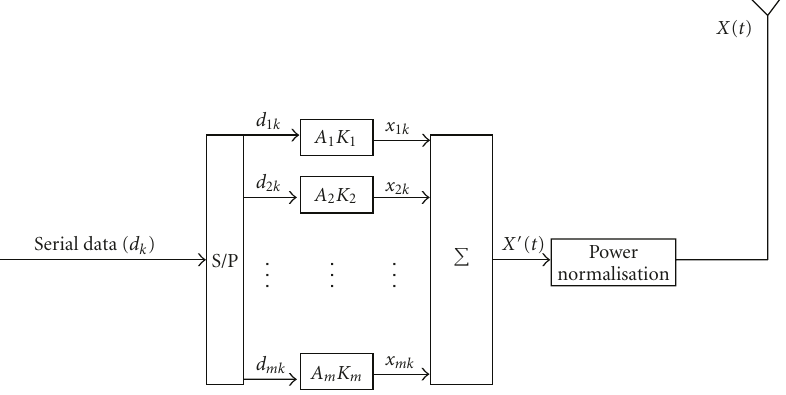
Figure 1: Conceptual block diagram of the new modulation scheme.